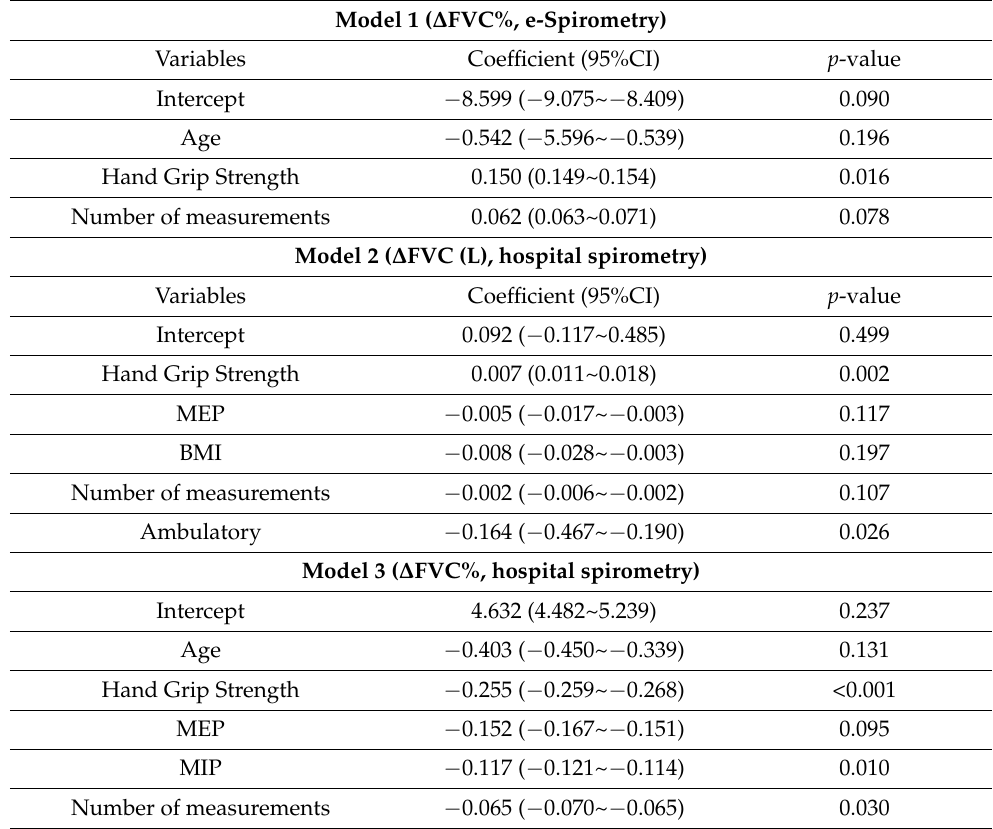
Table 6. Summary of stepwise linear regression models for predicting spirometry forced vital capacity (FVC (L) or ∆ FVC%) or with the clinical, anthropometric, and spirometry